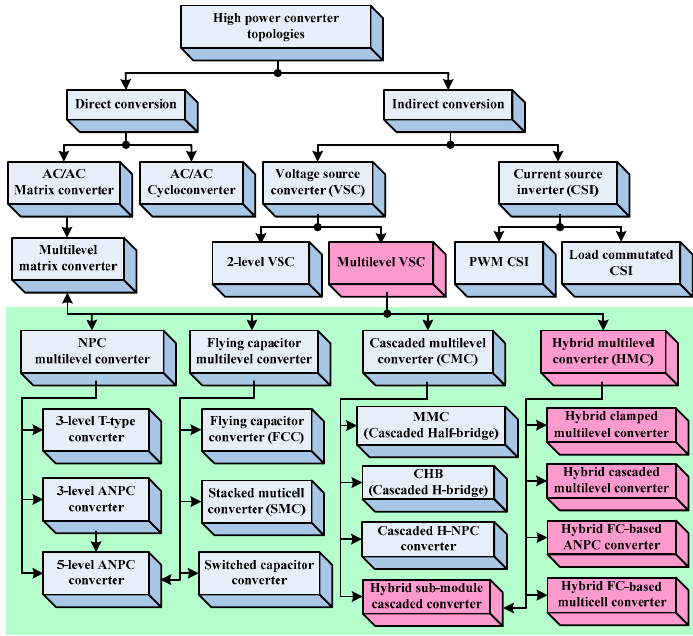
Figure 1. Classification of multilevel converters.